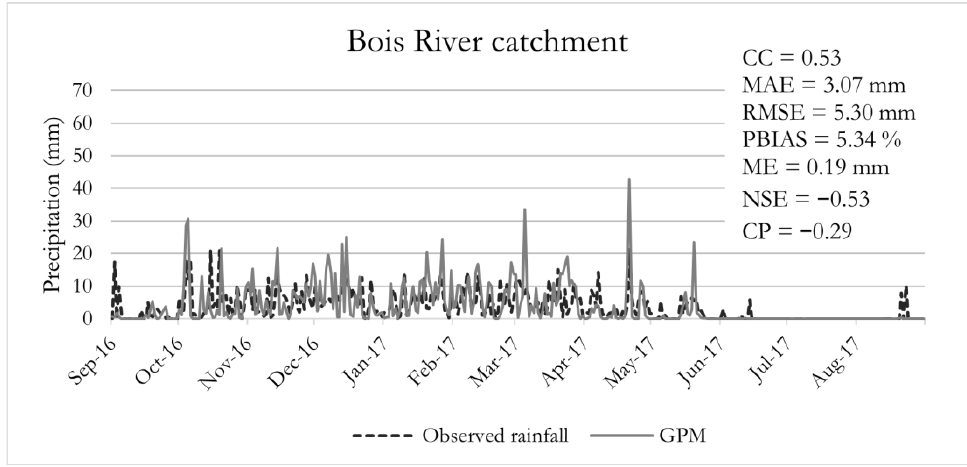
Figure 3. Comparison of the daily precipitation, as obtained from the GPM and the ground rainfall gauging network, averaged over the area of the Bois River catchment.